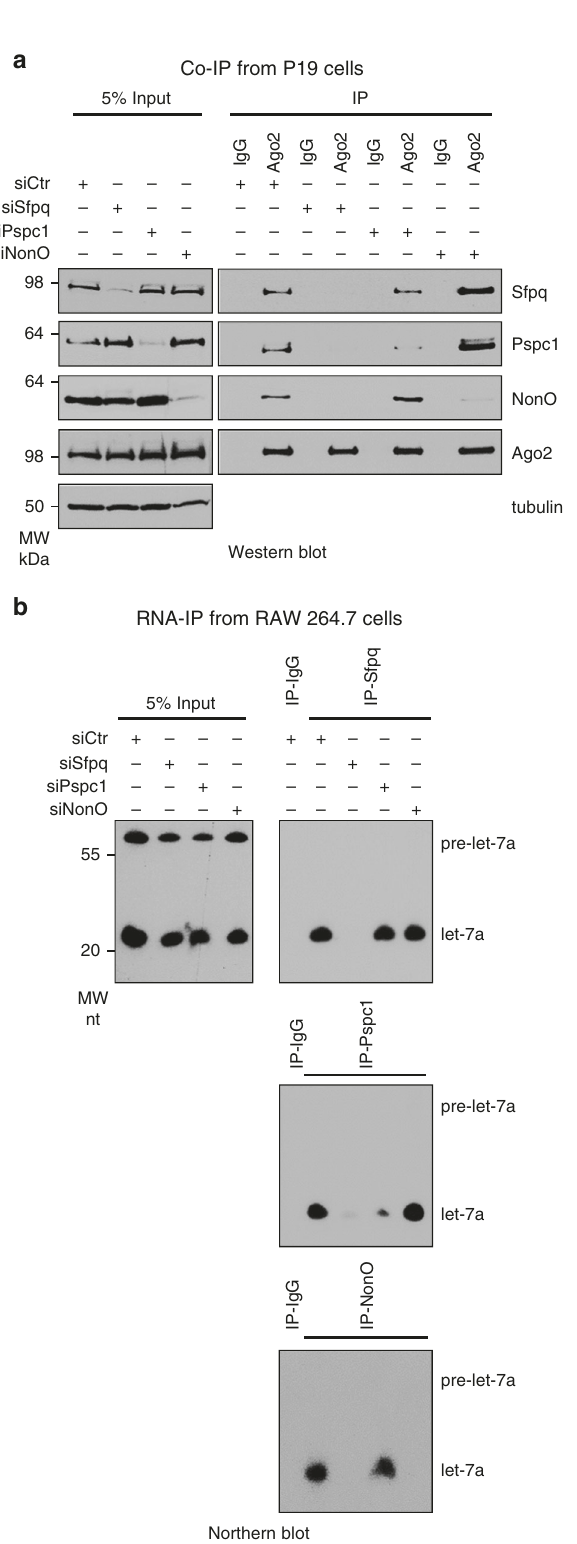
Fig. 2 Sfpq mediates the interaction between miRISC and Pspc1 or NonO. a Co-IP of endogenous Ago2 with Sfpq, Pspc1, or NonO from P19 cells. Cells were transfected with the indicated siRNAs and analyzed by Western blotting. Ago2 and tubulin served as controls. b RNA-IP of let-7a with the endogenous Sfpq, Pspc1, or NonO. RAW 264.7 cells were transfected with the indicated siRNAs. Cell extracts were immunoprecipitated with the indicated antibodies and the RNA was puri fi ed and analyzed by Northern